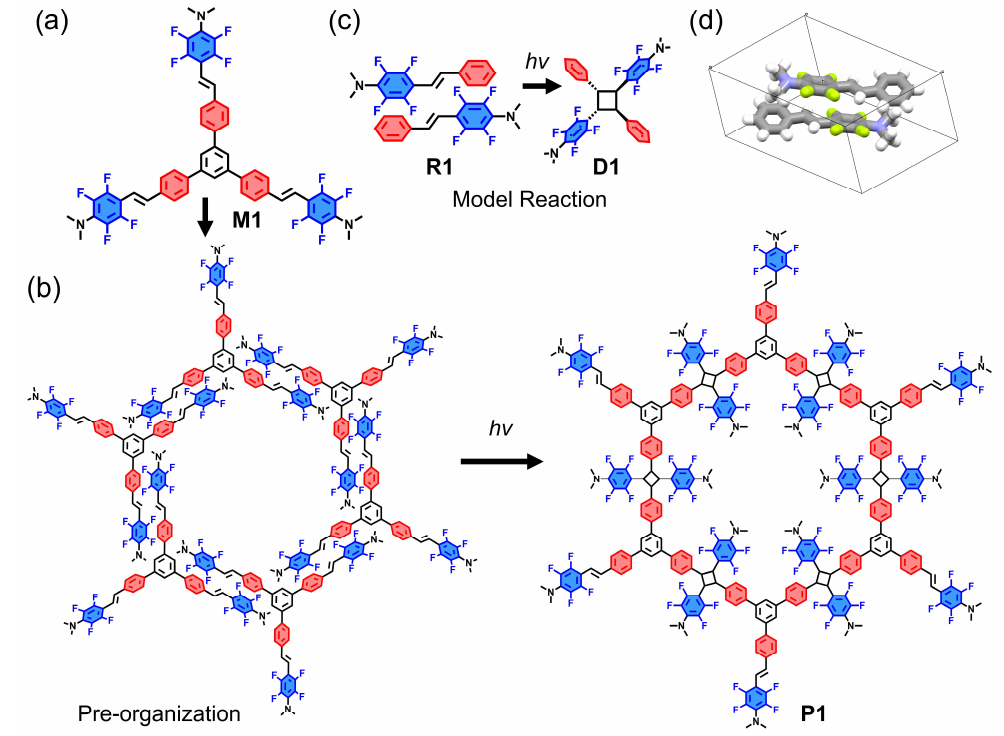
Figure 1. ( a ) The structure of monomer M1 . ( b ) The self-assembly process of M1 at the air/water interface and the polymerization under laser irradiation. ( c ) The structure of R1 and the corresponding dimerization of R1 to D1 . ( d ) The single crystal structure of R1 .